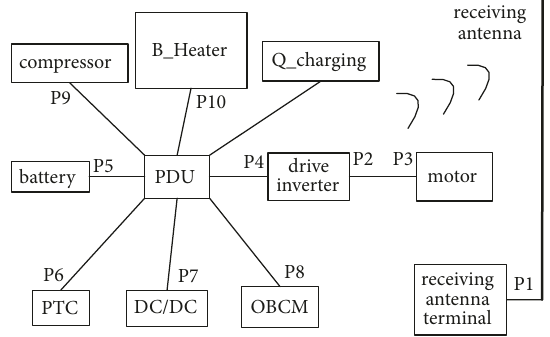
Figure 3: Multiport network of the